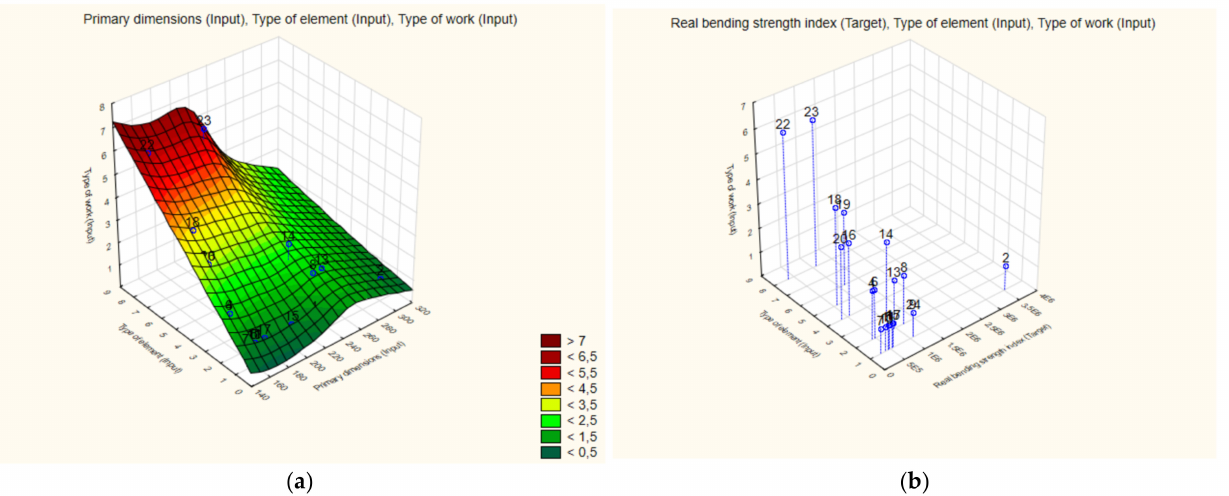
Figure 26. Prediction results: ( a ) 3D plane distribution conditional on work type, element type and original dimensions, ( b ) 3D histogram conditional on work, type, element type and actual strength index.